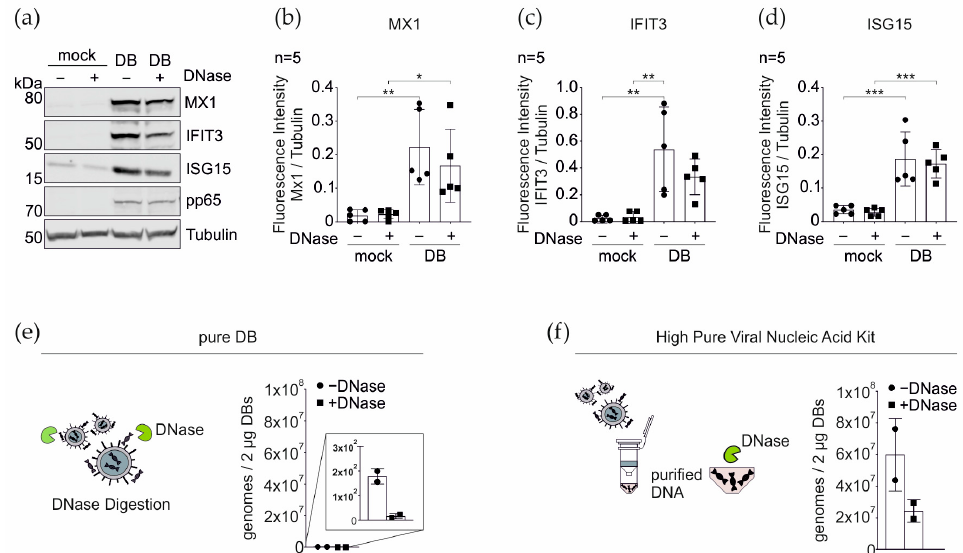
Figure 9. Western blot and qRT-PCR analyses of the impact of the DNase treatment of the purified DBs on the IRG expression and on the DNA detection in the purified DBs. Twenty μ g of TR- Δ GFP- DB were treated with DNase for 30 min at 37 °C and subsequently added to HFFs for 24 h. ( a ) Representative Western blot of the cell lysates of the mock and DB-treated cells, in the presence or absence of DNase, were analyzed for the expression of MX1, IFIT3, and ISG15. Tubulin was used as a loading control. DB internalization was monitored by the viral pp65 levels. ( b – d ) Quantification of the IRG expression levels in ( a ). The ratio of the fluorescence intensity of each IRG/tubulin band was measured. The values of the five independent experiments were plotted. Comparisons between groups were calculated using the unpaired t-test with Welch´s correction for the indicated group, compared with the untreated (mock) group. * p < 0.05; ** p < 0.01; *** p < 0.001. N = 5, five biological replicates ( e ) Schematic representation of the DNase digestion of DNA attached to the surface of the pure DBs. Twenty μ g of TR- Δ GFP-DB were digested with DNase for 30 min at 37 °C. For the genome determination, 2 μ g of DNase-digested and mock-treated DBs were subjected to the qRT-PCR analysis. ( f ) Schematic representation of the DNA extraction from the inside of DBs via the High Pure Viral Nucleic Acid kit. DNA from 20 μ g of TR- Δ GFP- DB was extracted and subjected for the DNase digestion. Two μ g of DNase-digested and mock-treated DBs were subjected to the qRT-PCR analysis for the genome determination. ● DNase-free sample, ▪ DNase-treated sample. Shown are the values of two biological replicates.